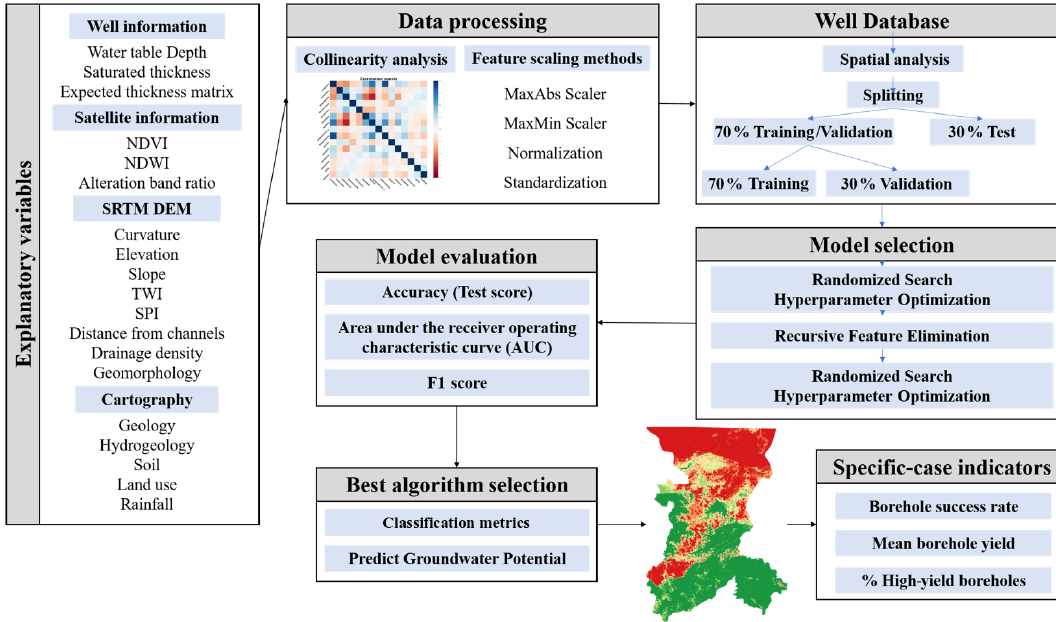
Figure 1. Conceptual model of the predictive mapping procedure with MLMapper